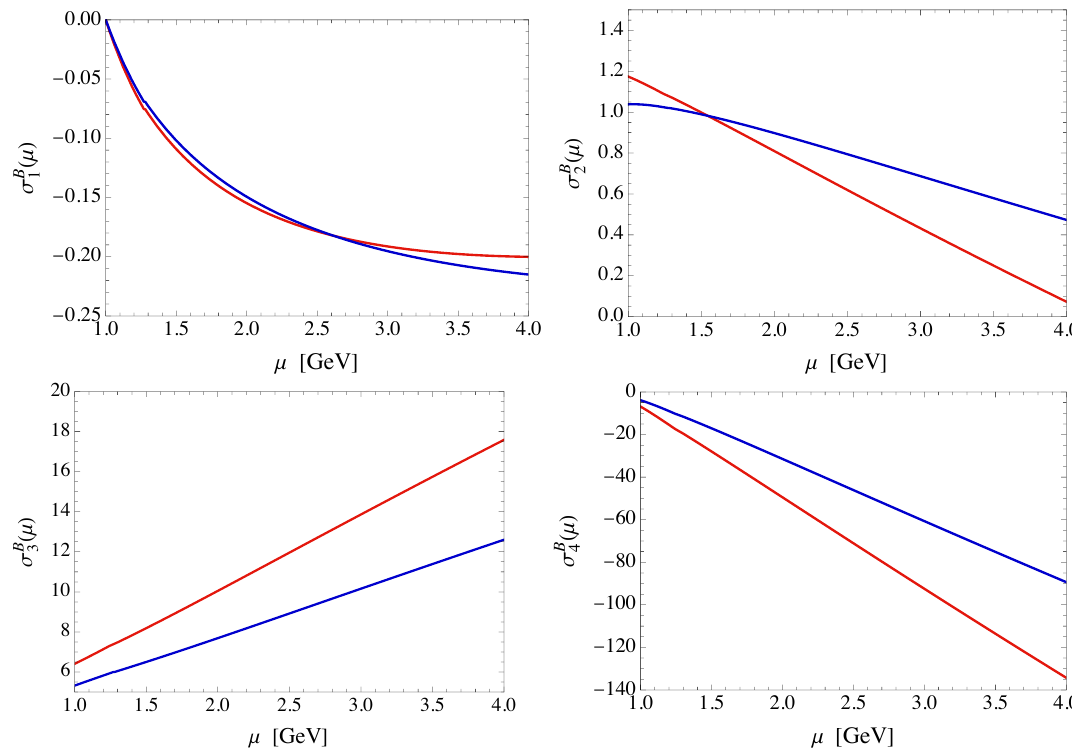
Figure 5 . Scale evolution of the first four moments σ B theory, for the two model functions with b = 0 (red curves) and b = − 2 . 07 (blue